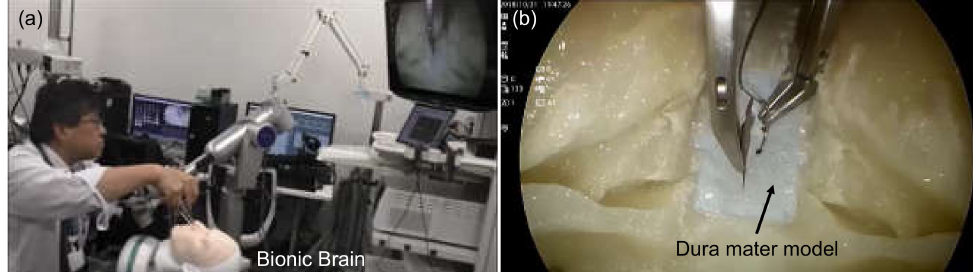
Figure 16. Surgeon sutures dura-mater model using a microscope and with other surgical tools: ( a ) A photograph during surgical simulation; ( b ) A image from the transnasal endoscope during suture of dura-mater